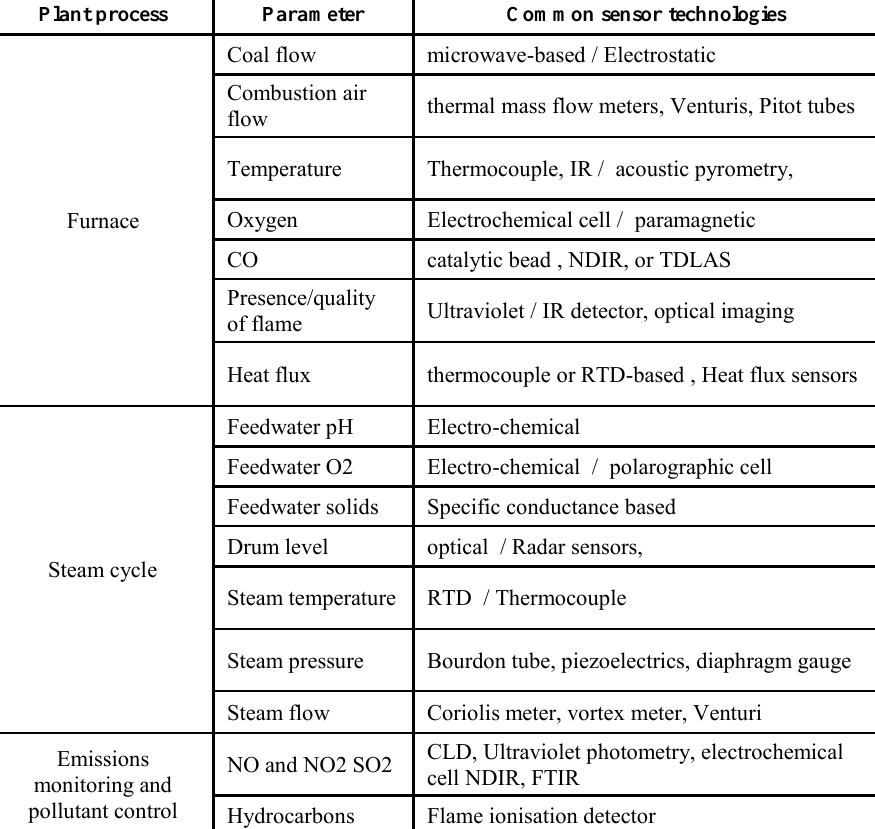
Table 1. Sensors used for different processes in various Plants emitting Hazardous Exhaust. Plant